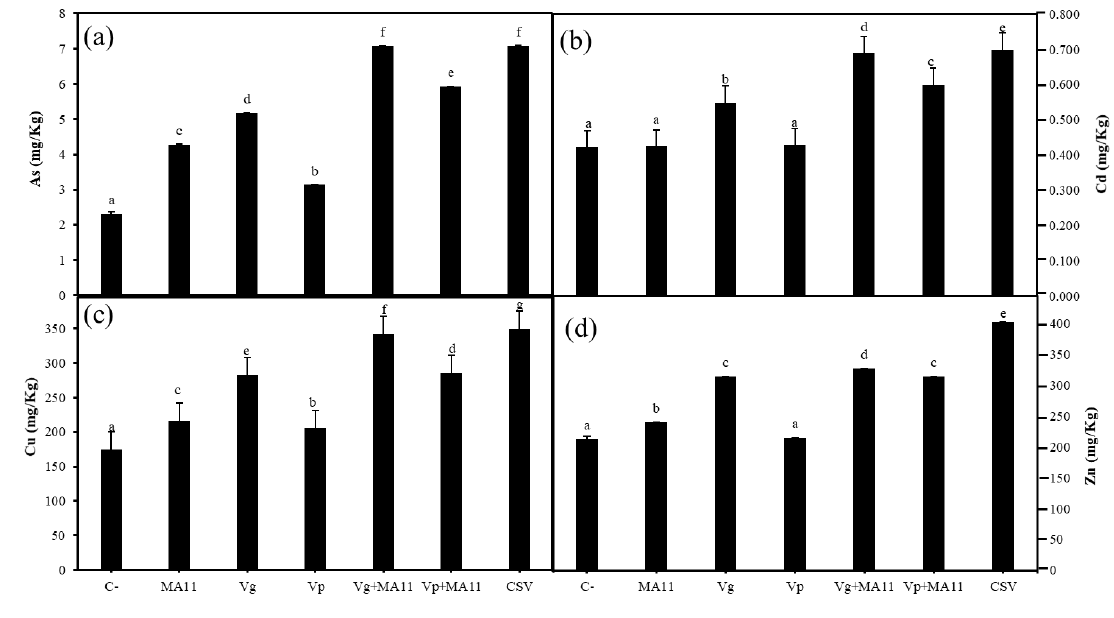
Figure 9. Metal/loid accumulation. ( a ) Arsenic, ( b ) cadmium, ( c ) copper, and ( d ) zinc accumulation in roots of M. sativa after 60 days in pots with nutrient-poor soils as a substrate under greenhouse conditions. Values are means ± S.D. ( n = 16). Different letters indicate means that are significantly different from each other (one-way ANOVA; LSD test, p < 0.0001). C – : non inoculation; MA11: in-